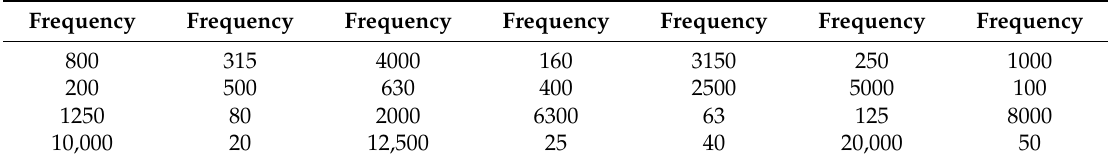
Figure 6. Graphical display of a correlation matrix. Table 2. Highly correlated variables with the target